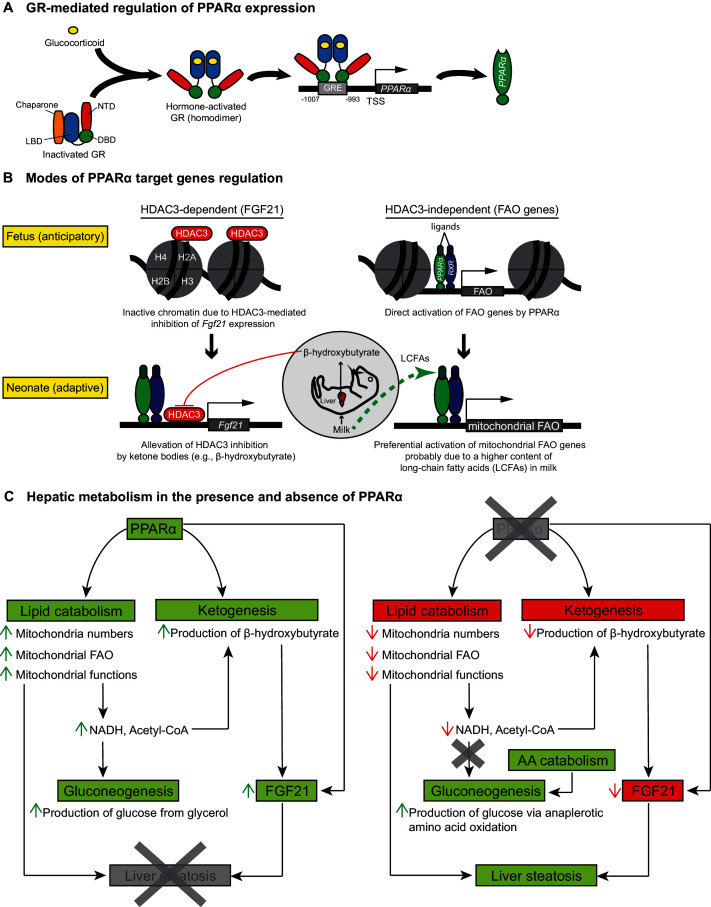
Schematic illustrations of GR-mediated regulation of PPARα expression, HDAC3-dependent and -independent regulation of PPARα target genes before and after birth, and the affected liver metabolic processes with or without PPARα.(A) In fetal liver, hormone-activated GR binds to the GR response element (GRE) spanning -1007 to -993 within the PPARα promoter region to directly activate the transcription of Ppara. NTD: N-terminal domain, LBD: ligand-binding domain, DBD: DNA-binding domain. (B) At E19.5, direct binding of HDAC3 near the TSS of Fgf21 leads to the repression of Fgf21 transcriptional activity. Upon milk suckling, PPARα-dependent production of β-hydroxybutyrate from the neonatal liver alleviates the HDAC3-mediated repression of Fgf21 by directly inhibiting the activity of HDAC3, permitting PPARα-dependent Fgf21 expression. Activated GR leads to the stimulation of PPARα and its target genes in fetal liver, such as those involved in mitochondrial and peroxisomal fatty acid oxidation (FAO). After birth, the expression of PPARα target genes involved in mitochondrial FAO predominates the expression of genes involved in peroxisomal FAO, probably due to the higher long-chain fatty acid (LCFA) content than very-long-chain fatty acid (VLCFA) content in the milk. (C) Schematic illustration depicting the affected processes of hepatic metabolism in the presence and absence of PPARα. Green boxes/arrows indicate increments; reds indicate decrements.